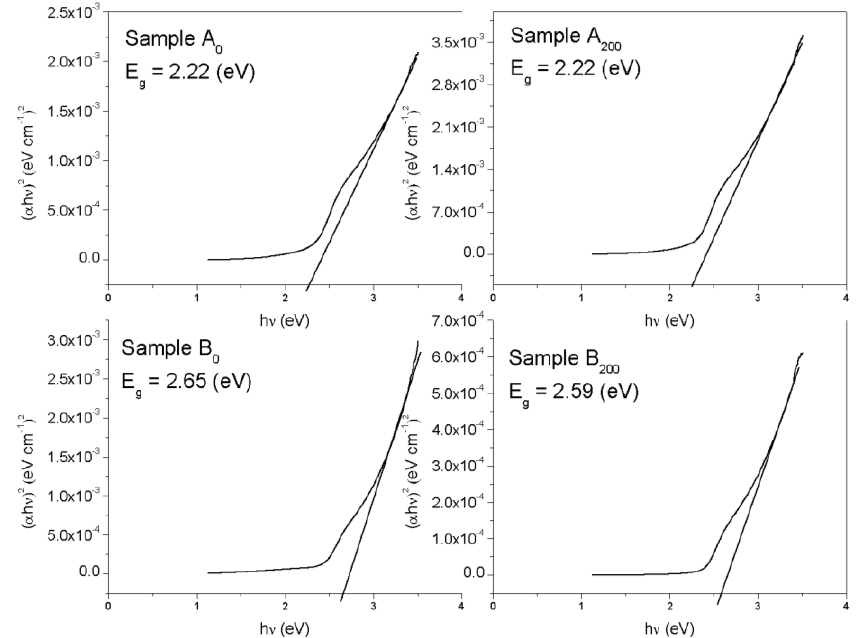
Figure 7. Variation of the optical energy band gap ( E concentrations and annealing temperatures.